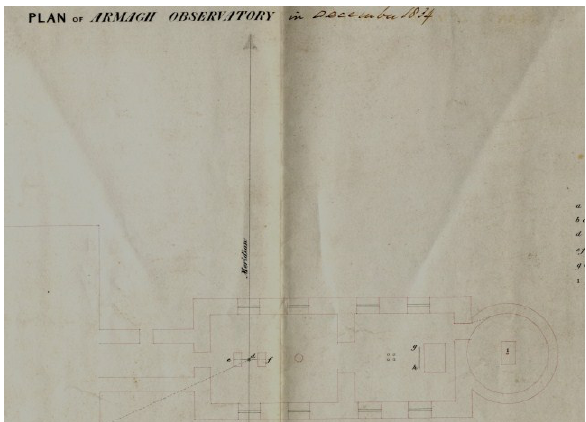
Figure 12: Observatory Plan Showing Location of Meridian